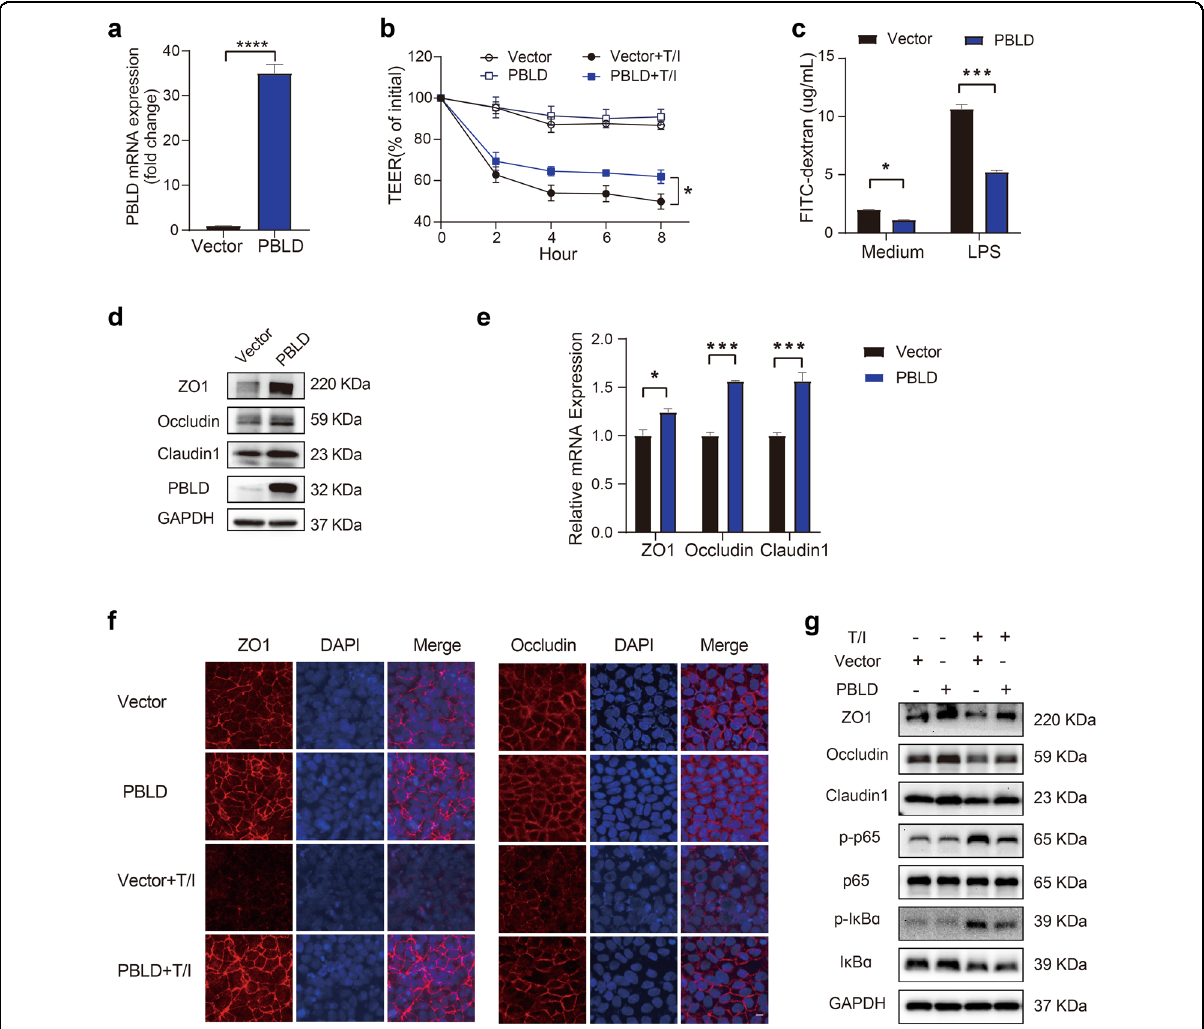
Fig. 4 PBLD protects epithelial barrier function in Caco2 cell monolayers by improving TJ protein expression. a Caco2 cells were transfected with PBLD-expressing lentivirus or control lentivirus vector, then the expression of PBLD was assessed by qRT-PCR. b Transepithelial electrical resistance (TEER) curves from Caco2 monolayers transfected with PBLD-expressing lentivirus or control lentivirus vector with or without incubation with 10 ng/mL TNF- α /IFN- γ . c Caco2 monolayers transfected with PBLD-expressing lentivirus or control lentivirus vector was incubated with or without 50 ng/mL LPS for 2 h, then FITC-dextran fl ux was measured after 2 h incubation in upper chamber. d Immunoblotting analysis and ( e ) qRT- PCR analysis of proteins and genes in Caco2 monolayers transfected with PBLD-expressing lentivirus or control lentivirus vector. f Immuno fl uorescent staining of ZO-1 and occludin in Caco2 monolayers transfected with PBLD-expressing lentivirus or control lentivirus vector with or without 10 ng/mL TNF- α /IFN- γ incubation for 24 h. Scale bars: 10 μ m. g Western blot analysis of indicated proteins in Caco2 monolayers, as described in ( f